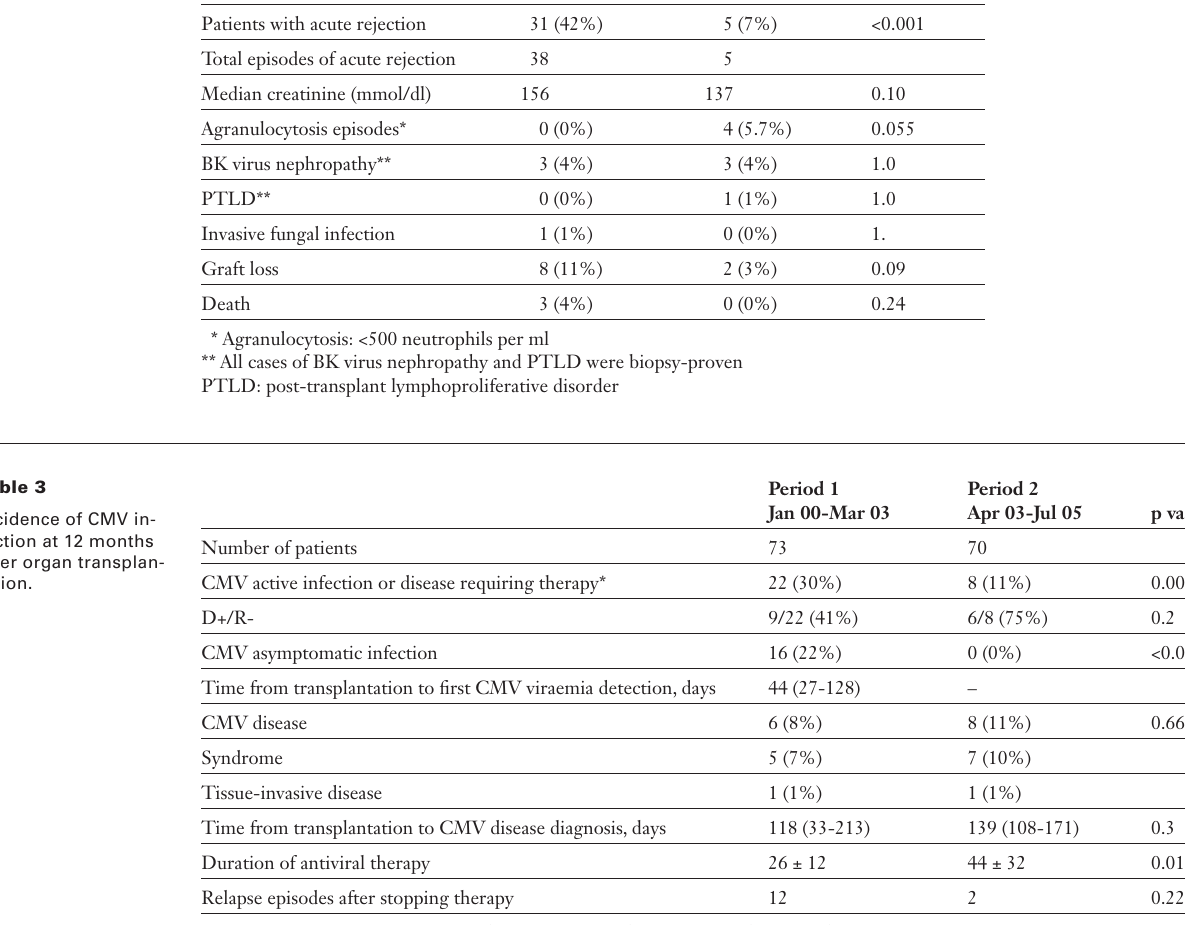
Patient outcome after 12-month follow-up.